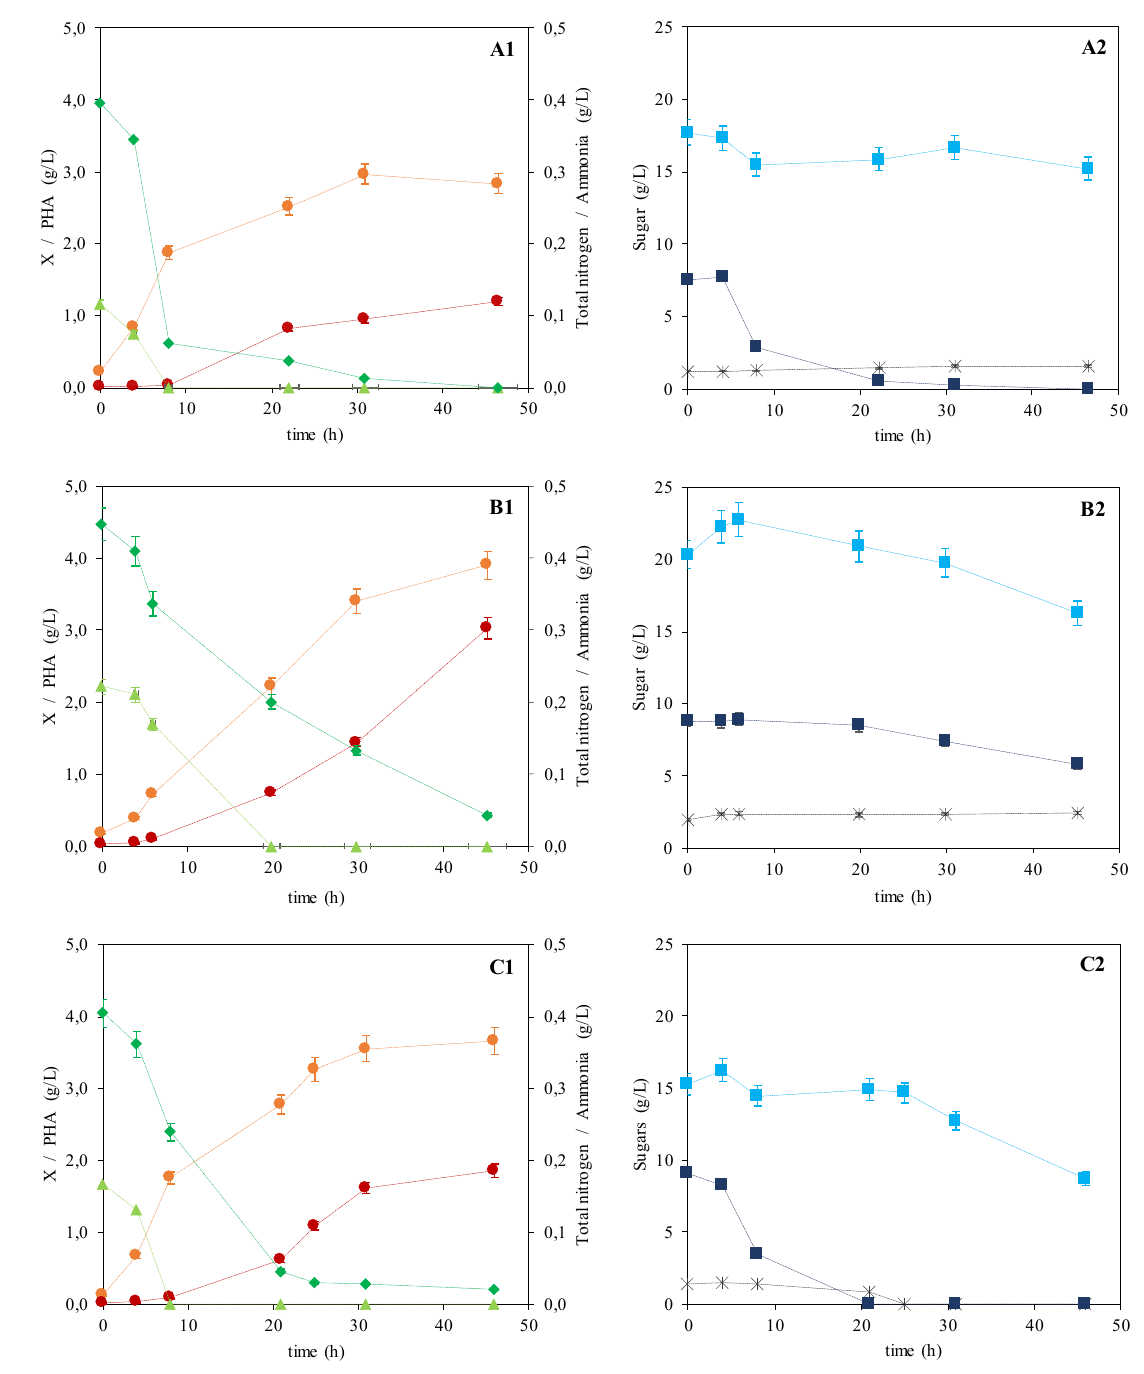
Figure 1. Cultivation profile for the monocultures of P. citronellolis (adapted from Rebocho et al. [21]) and C. necator ( A and B , respectively), and the co-culture of C. necator and P. citronellolis ( C ), using apple pulp extract as the sole carbon source (( 1) : rest biomass, ; PHA, ; total nitrogen, ; ammonia, ; ( 2) : glucose, ; fructose, ; sucrose, ; error bars correspond to duplicate analyses).